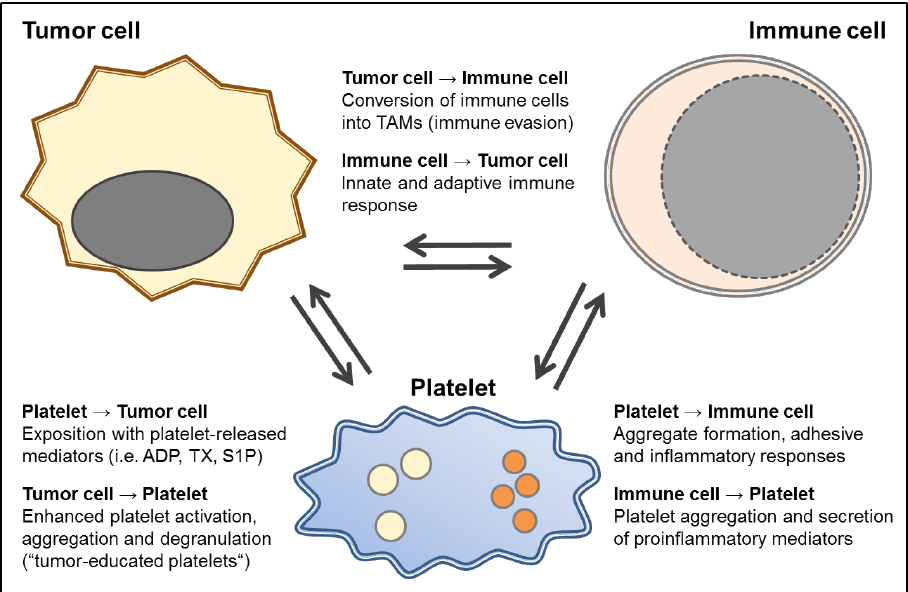
Figure 1. A scheme of the multiple and mutual interactions between tumor and immune cells and platelets. Platelets and tumor cells interact at various levels. Platelet-derived paracrine mediators